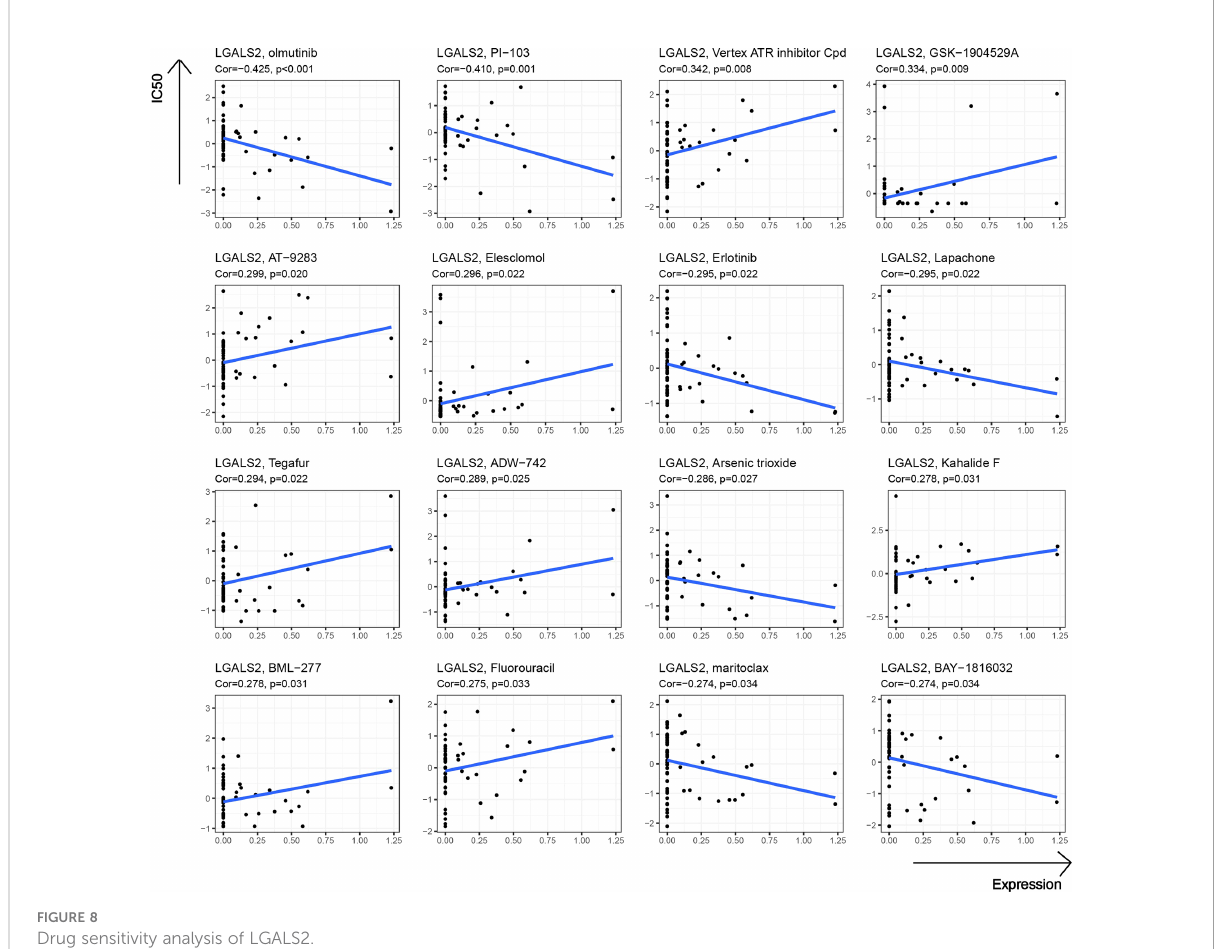
FIGURE 8 Drug sensitivity analysis of